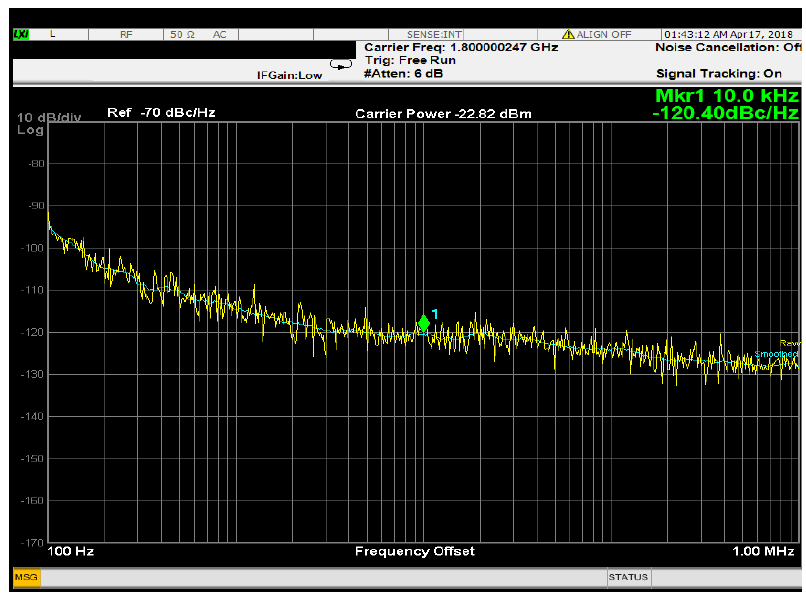
Fig. 8. The dependence of NSPD value obtained with offset up to 1 MHz of the oscillator stabilized by the PLL loop with frequency division by